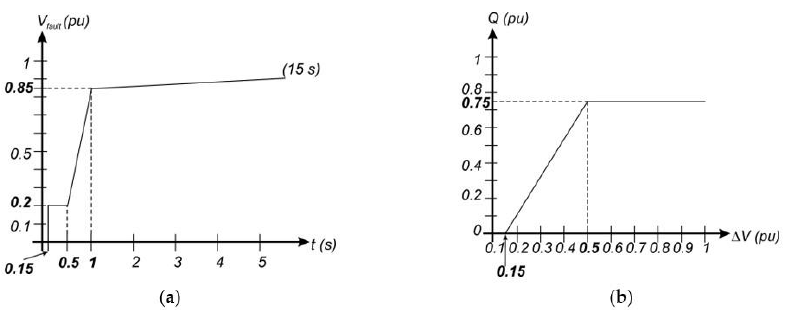
Figure 2. ( a ) LVRT requirements according to the IEC 61400-21 standard [22,23] and ( b ) proper Q delivered to the utility grid according to the normalized depth of voltage sags from the example of Spain ( ∆𝑉 (pu) = 1 − 𝑉 𝑓𝑎𝑢𝑙𝑡 ) [24].